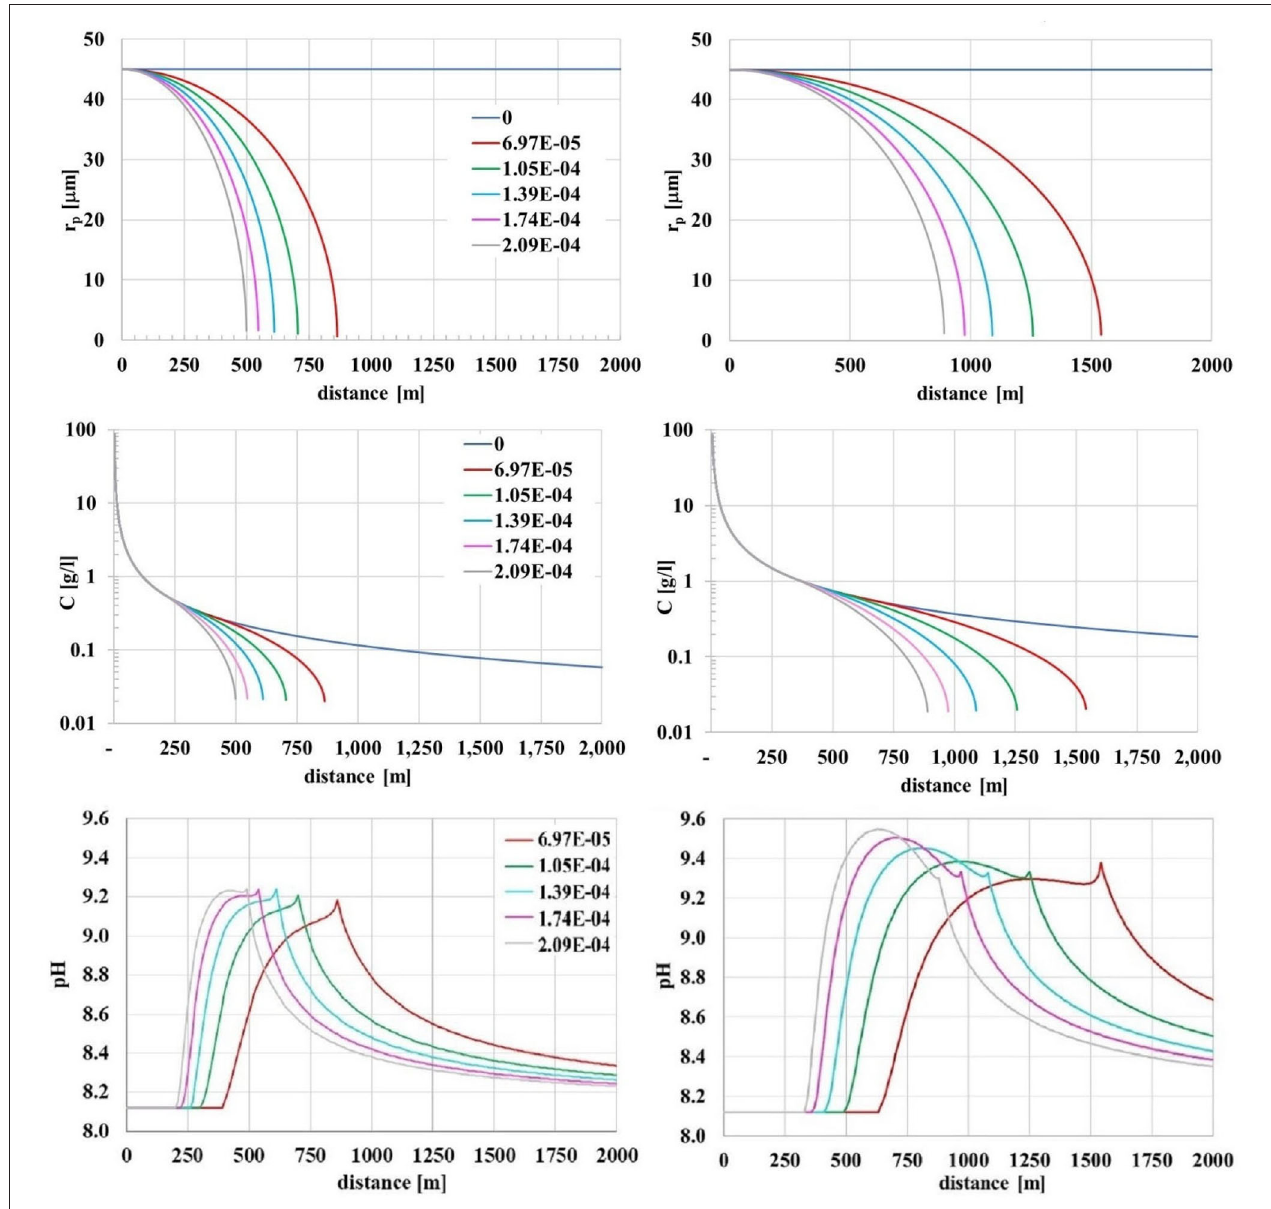
FIGURE 5 | Particle radius (top), Ca(OH) 2 concentration (middle) and pH variation (bottom) for different values of the diffusion potential φ 0 and two rate of discharge (left: 10 kg/s; right: 100 kg/s). Initial Ca(OH) 2 particle radius: 45 µ